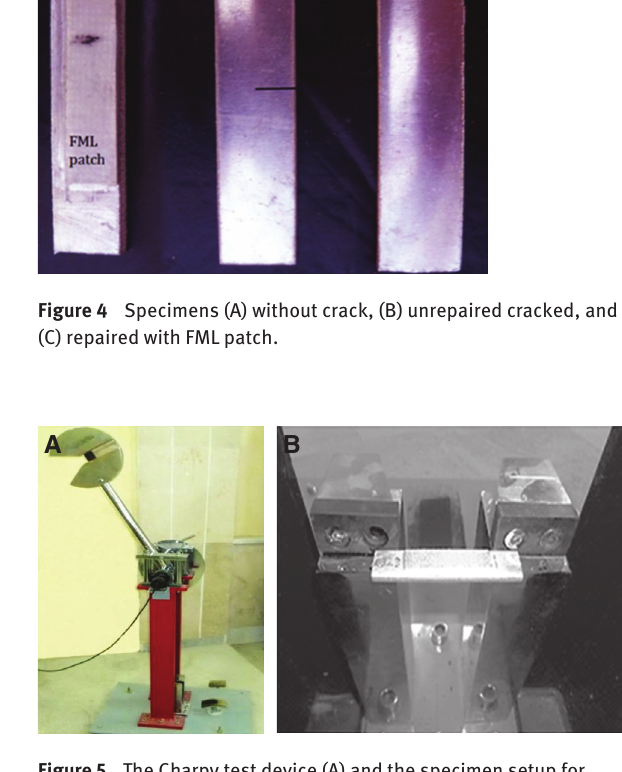
Figure 5 The Charpy test device (A) and the specimen setup for testing (B).